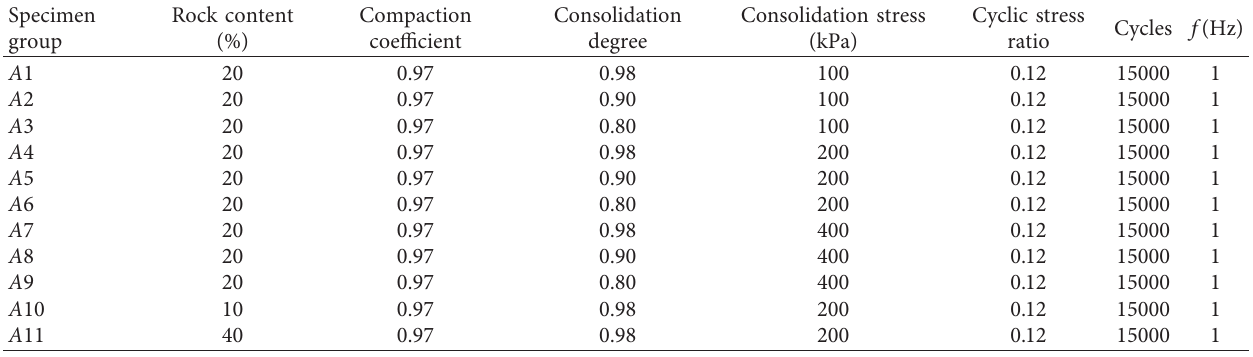
Table 2: Stiffness softening test program.